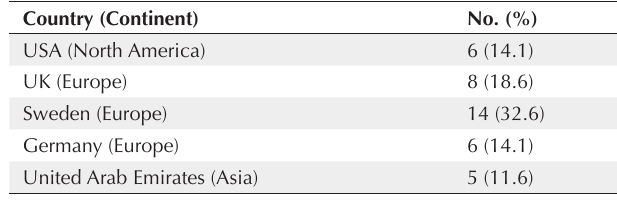
Table 1. Country Profile of Study Participants (n = 43) Country